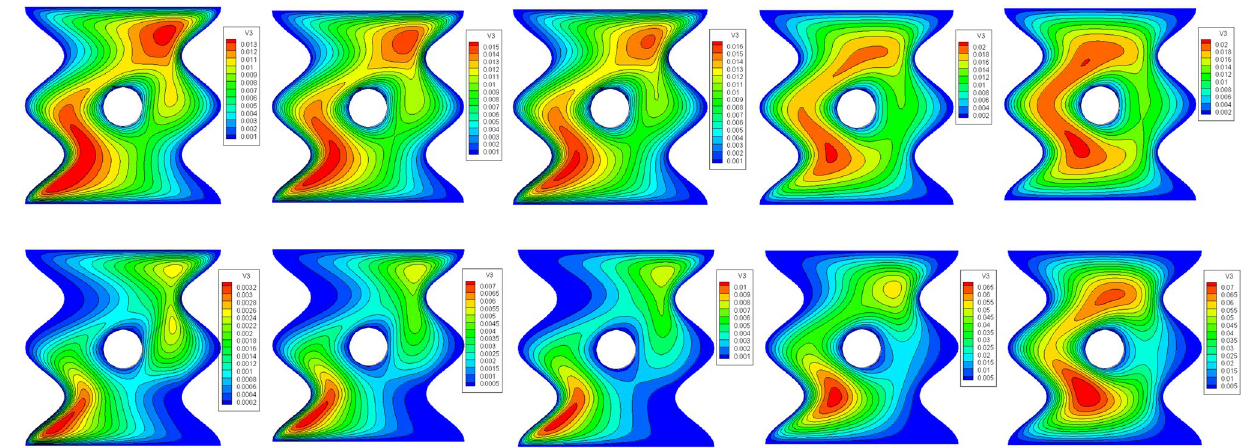
values; Ha = 10 , Q = 1 , H * = 10 , R = 0 . 5 , ε = 0 . 5 , γ = 0 . 5 , Φ = π/ 3 , λ = , d α = π/ 3 , ϕ = ϕ = ϕ / 2 , ϕ = 0 . Cu TiO 2